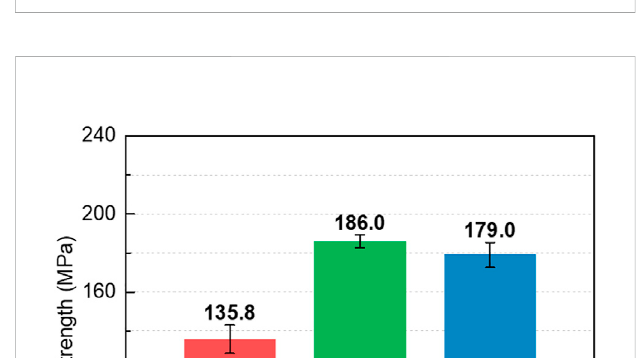
FIGURE 2 Dimensions of dumbbell